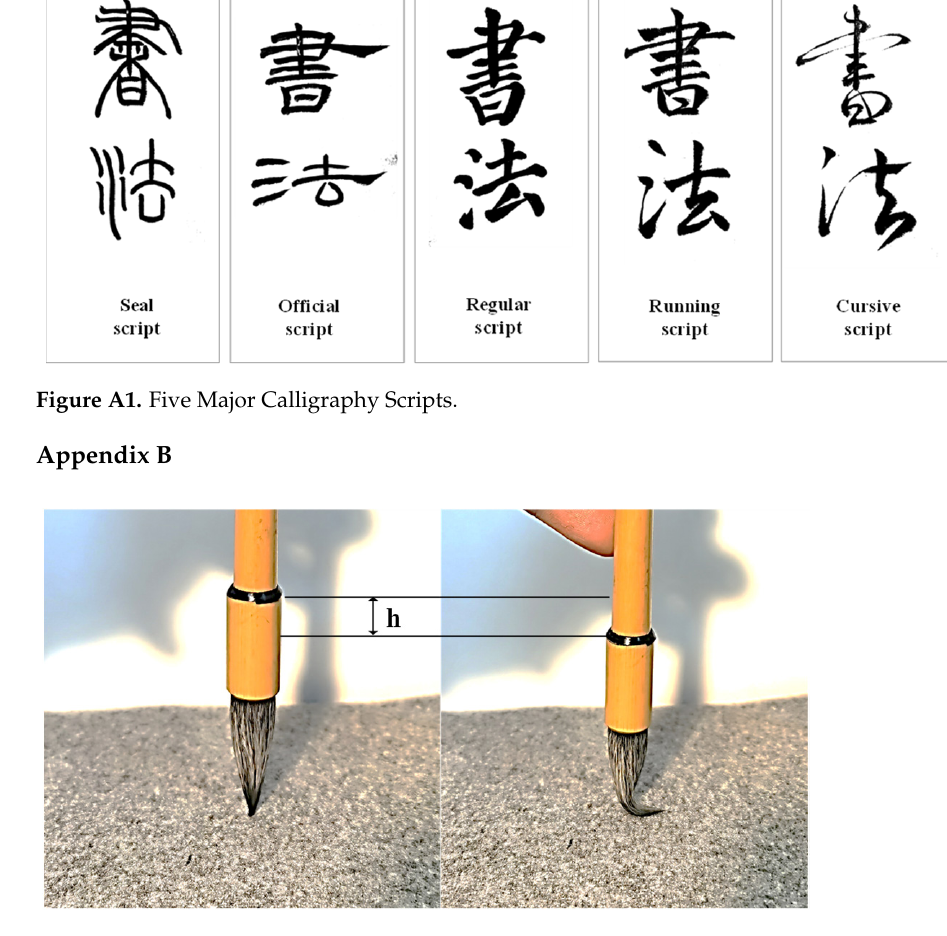
Figure A2. original stroke depth (left) and writing stroke depth (right).